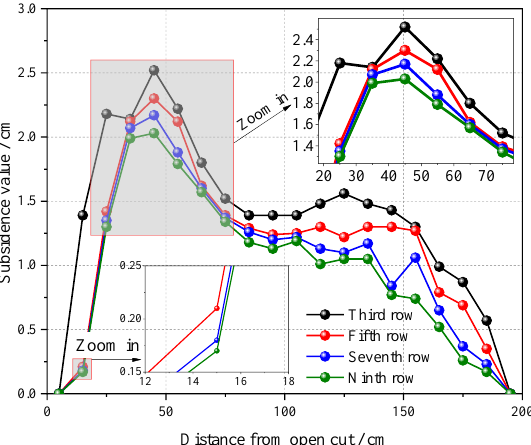
Figure 7. Overburden migration rule before and after mining.